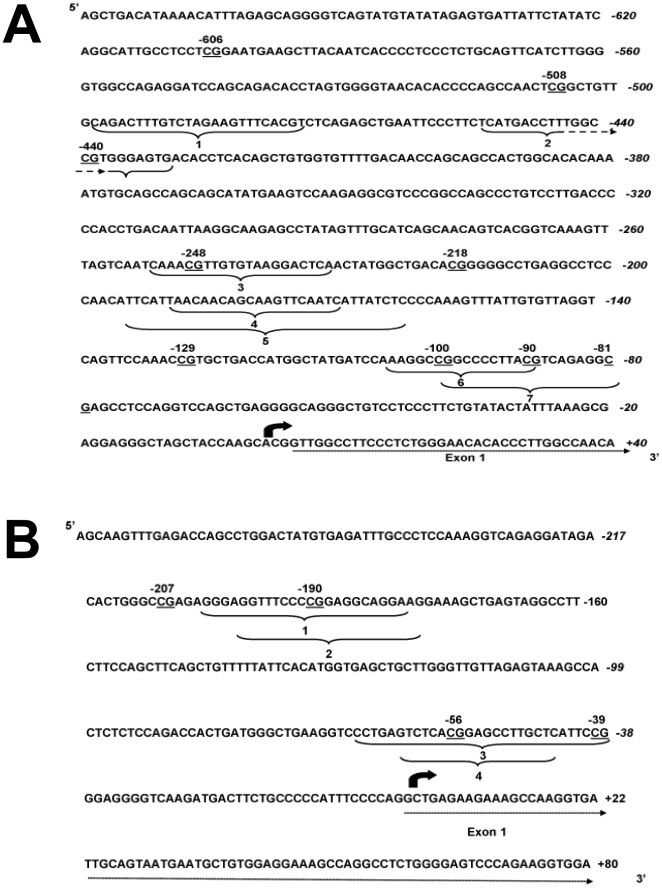
Structure of the phosphoenolpyruvate carboxykinase and DNA methyltransferase 3a promoters.Genomic sequence of the region of the (A) phosphoenolpyruvate carboxykinase promoter analysed for CpG methylation. CpG reported in the methylation analysis are underlined. Known transcription factor response elements are indicated by curved brackets; (1), heat shock factor, (2) PPAR, (3) CATT enhancer-binding protein, (4), glucocorticoid receptor (5) hepatic nuclear factor-1, (6), Krueppel-like transcription factors, (7) cAMP-response element [38]. (B)Genomic sequence of the region of the DNA methyltransferase 3a2 promoter analysed for CpG methylation. CpG reported in the methylation analysis are underlined. Putative transcription factor response elements are indicated by curved brackets; (1) nuclear factor of activated T cells, (2) retinol x receptor, (3) neurone-restrictive silencer factor, (4) mouse Krueppel factor.